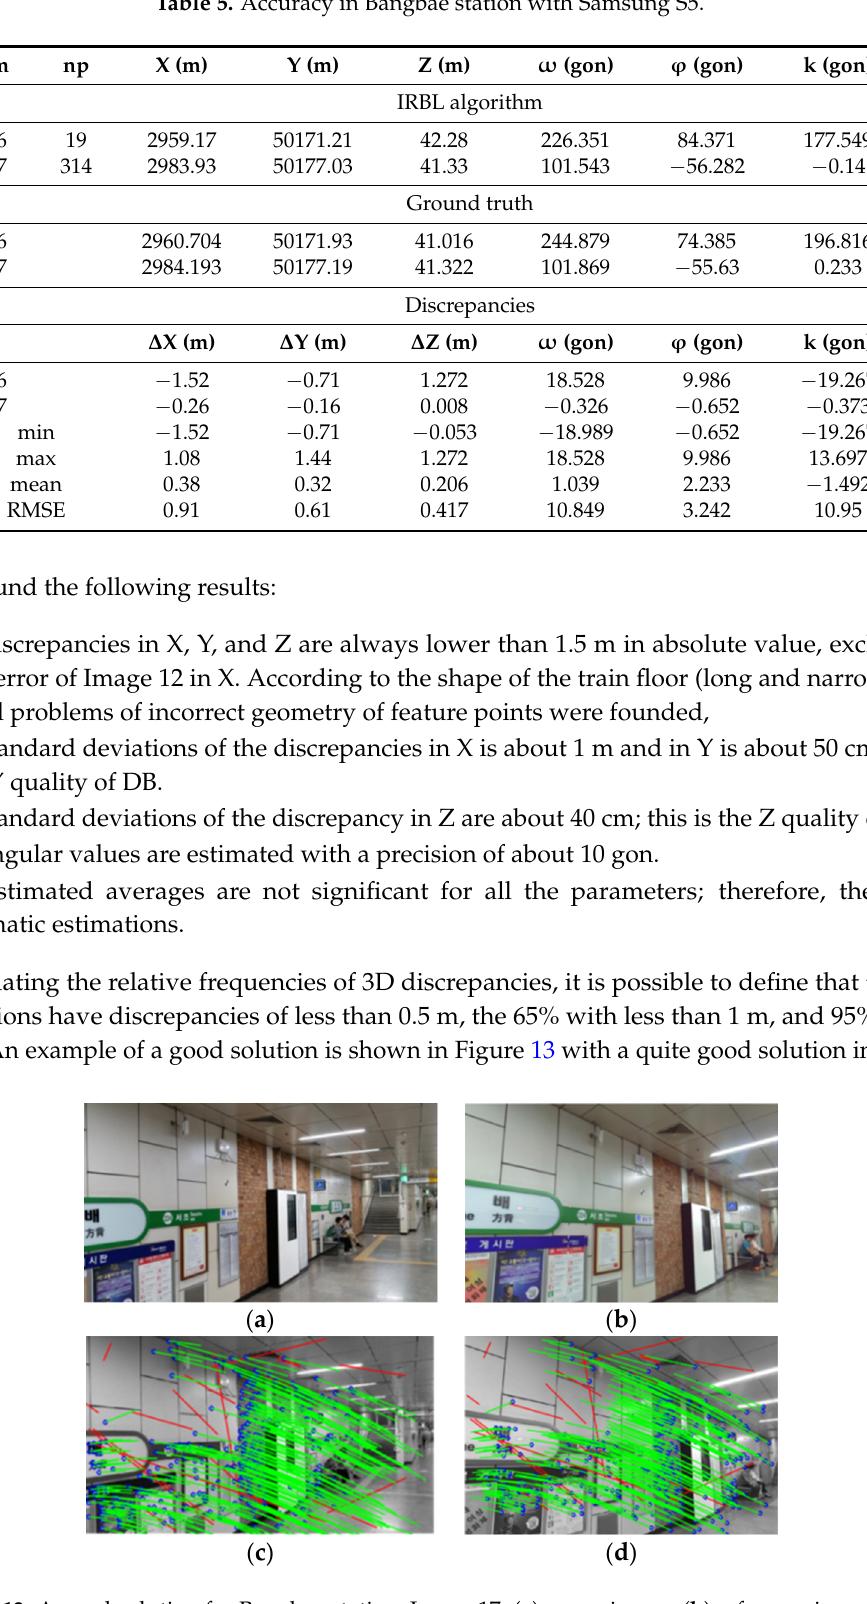
Table 5. Accuracy in Bangbae station with Samsung S5.